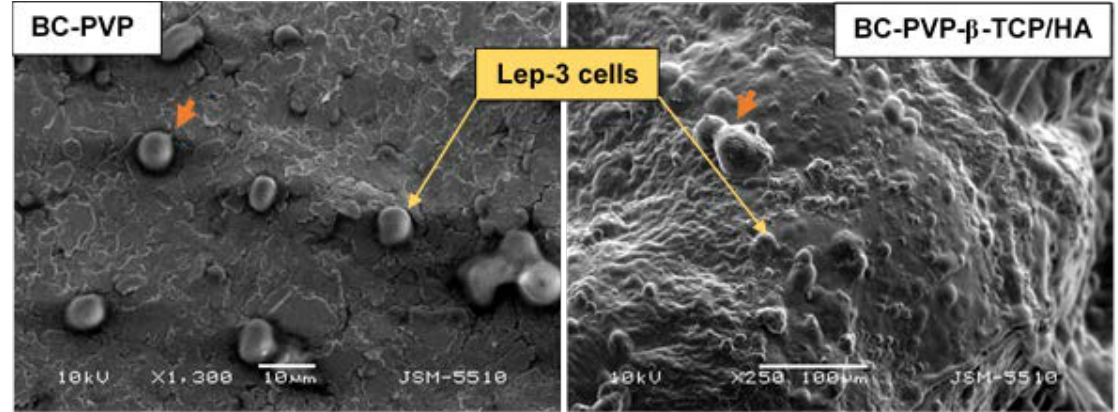
Figure 4. SEM images of Lep-3 cells grown on BC based hydrogel (BC-PVP and BC-PVP- β -TCP/HA). The orange colored arrow indicates developing projections.